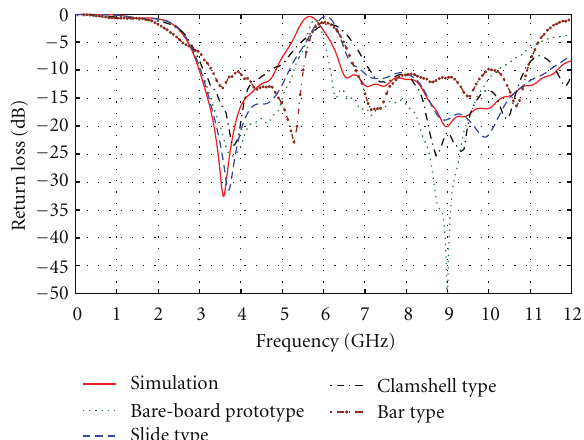
Figure 8: Measured return loss of the proposed antenna for the various mobile